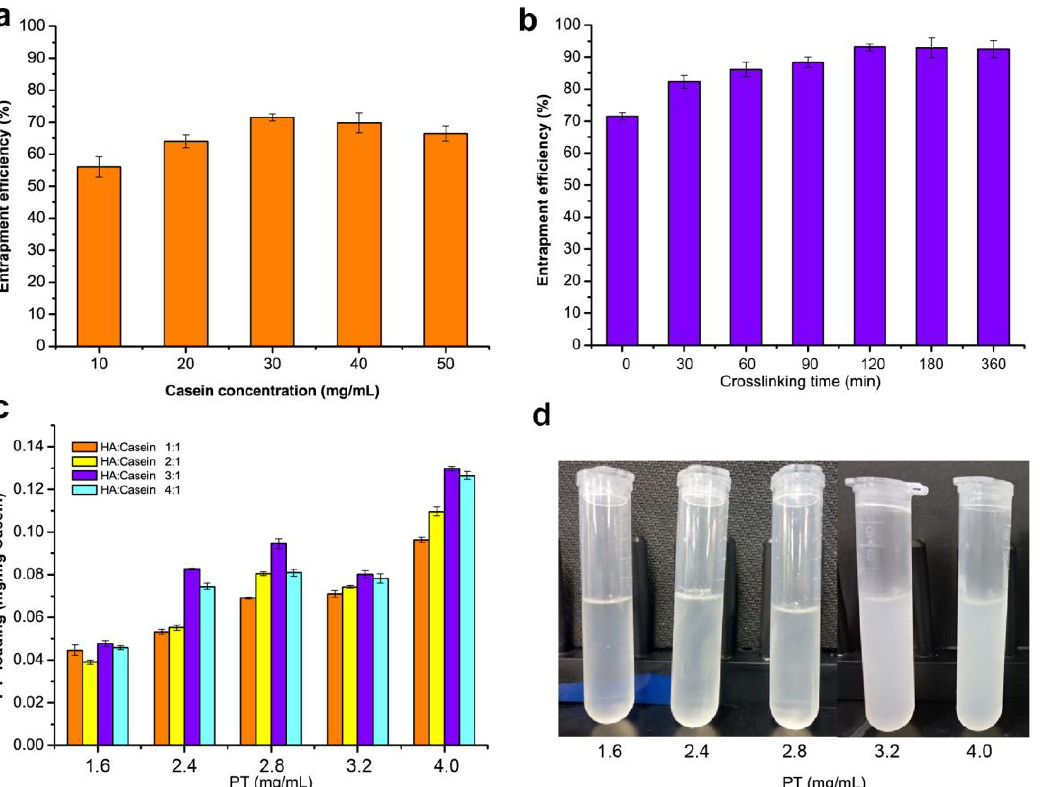
Figure 1. Evaluation of nanoparticles formulation with various concentrations of casein and hyaluronic acid oligosaccharides. ( a ) Effect of casein concentrations on entrapment efficiency. ( b ) Analysis of the entrapment efficiency of nanoparticles with crosslinking time of HA and casein. ( c ) Effects of paclitaxel (PT) concentrations and the HA/casein values on the PT loading of nanoparticles. ( d ) Effect of the PT concentrations on the turbidness of nanoparticles.